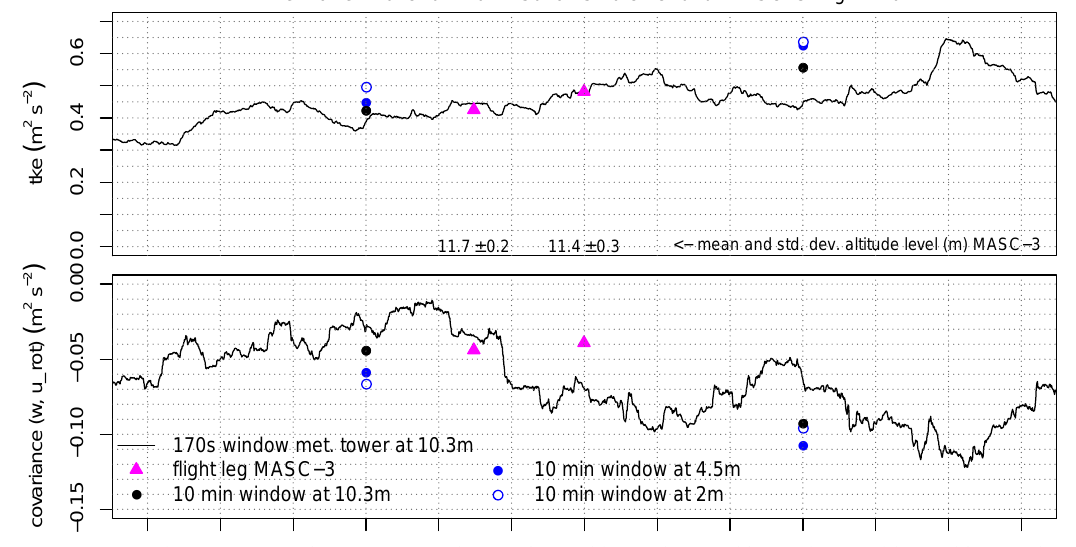
Figure 12. Time series of the tower with the corresponding leg averages of MASC-3 at the lowest flight levels for the turbulent kinetic energy (TKE) ( top ) and the covariance of the vertical and horizontal wind component Cov wu ( bottom ). By 2D double rotation for the tower and by coordinate transformation rot with the mean wind direction of the individual MASC-3 flight legs, u rot was aligned with the mean wind direction. The mean altitude and standard deviation of the individual flight leg is given for the MASC-3 data points. The data of the tower at 10.3 m is calculated on a moving window with the length of ∆ t tower = 170 s corresponding to the fetch of the MASC-3 flight legs with an average duration of ∆ t UAS = 80 s. Furthermore the neighboring ten minute averages of the tower at all height levels are